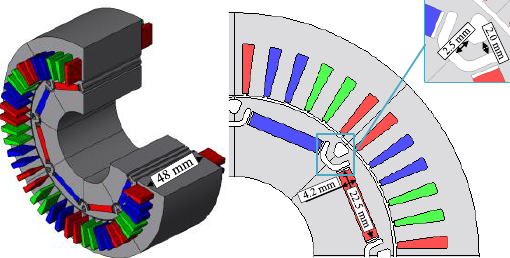
Figure 18. Analysis model of variable leakage flux motor. Table 4. Specifications of compared motors.